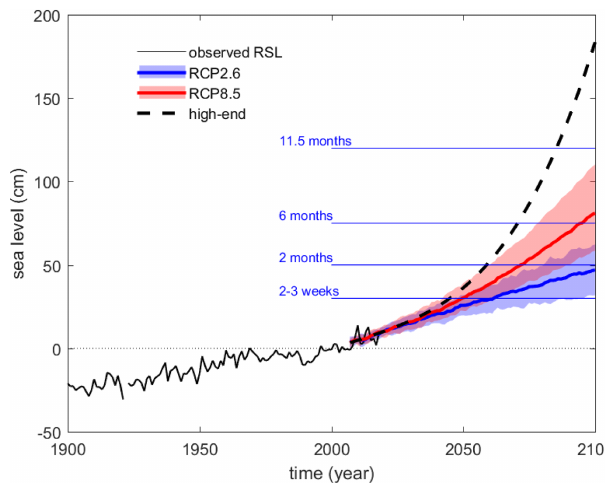
Figure 5. Projected relative sea level change in Venice in the con- text of historical observations. Observations are the annual mean tide gauge relative sea level height anomalies with respect to the 2000–2007 average. Projections are based on two reference scenar- ios of anthropogenic greenhouse gas emissions, namely Represen- tative Concentration Pathway 2.6 (RCP2.6; low emission scenario) and RCIP8.5 (strong emission scenario), and a high-end scenario illustrating a plausible evolution obtained by combining the high- est estimates of all individual contributions to relative sea level rise (shading – 5–95 percentile range; line – median). The horizontal blue lines show the relative mean sea level thresholds for annual persistence of the relative sea level above the present safeguard level (persistence durations of 2–3 weeks; 2, 6, and 11.5 months have been considered). These time intervals approximately correspond to the annual duration of the expected closures of